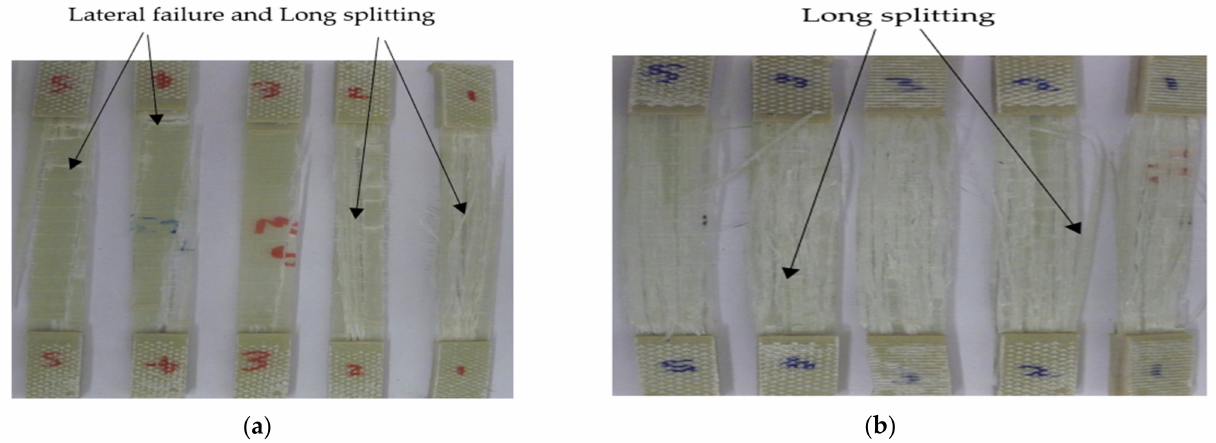
Figure 4. Failure modes of unidirectional GFRP laminates at testing temperatures: ( a ), − 20 ◦ C ( b ), 75 ◦